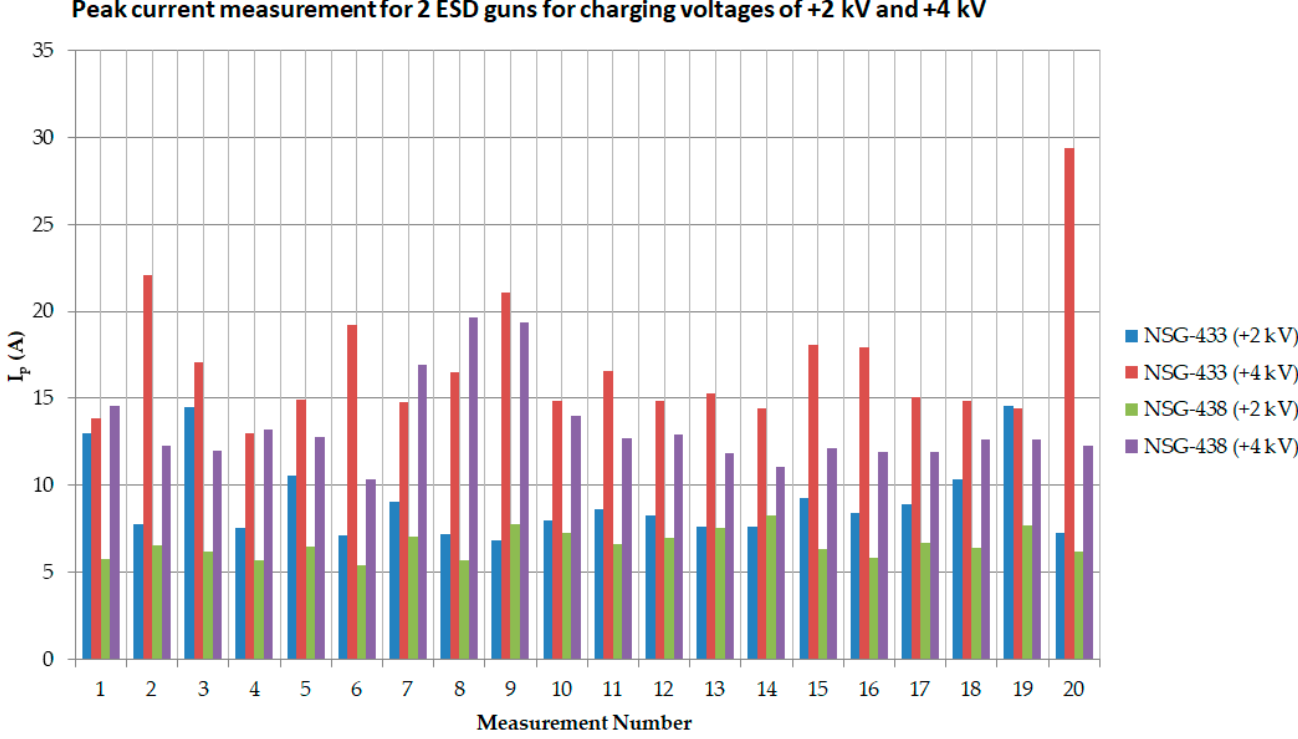
Figure 7. Peak current measurements for the two ESD guns for charging voltages of +2 kV and +4 kV.